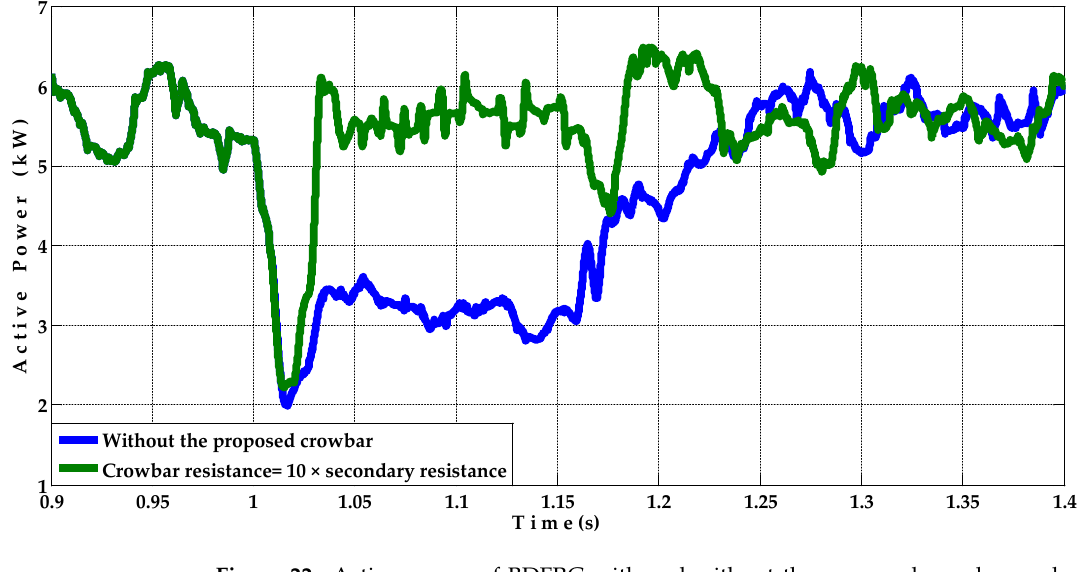
Figure 22. Active power of BDFRG with and without the proposed crowbar under line to line fault occurrence.